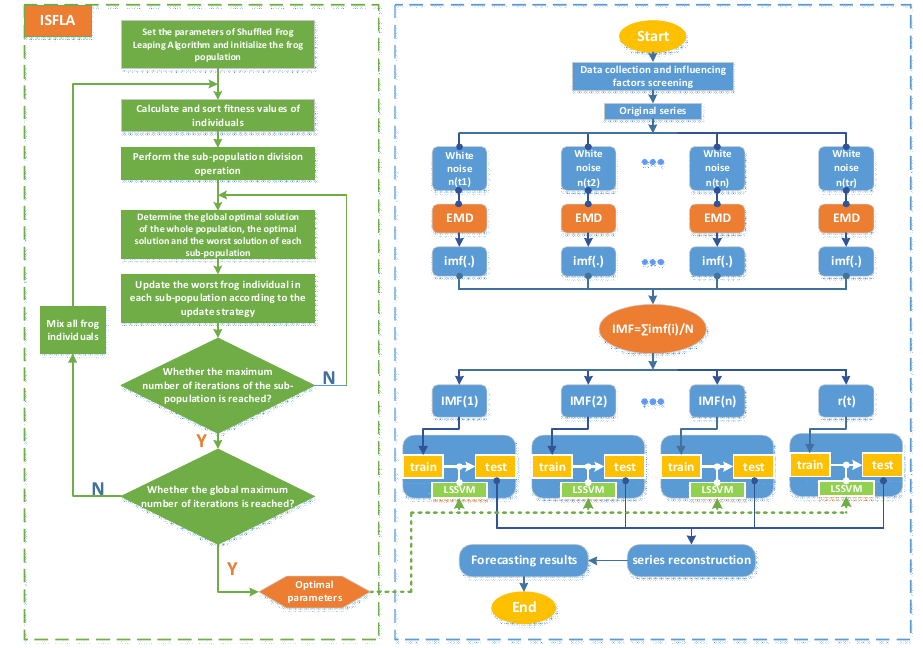
Figure 3. The flowchart of EEMD-ISFLA-LSSVM.